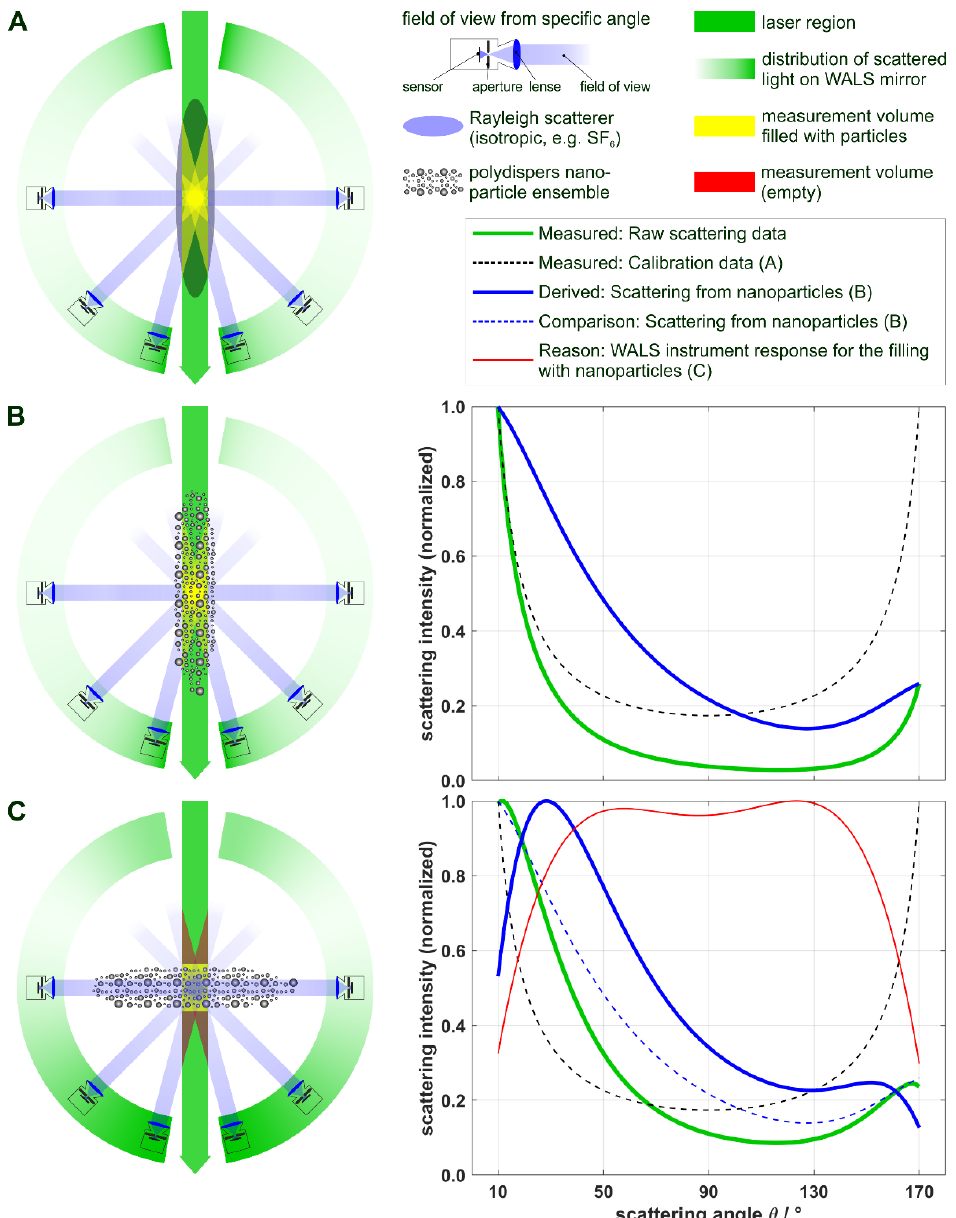
Figure 4. Illustration of WALS scattering patterns for isotropic scatterers ( A ) and a polydisperse particle ensemble ( B ), both filling the measurement volume homogeneously and completely; a non-homogeneous filling of the measurement volume and its characteristic scattering pattern is depicted in ( C ); scattering diagrams next to ( B , C ) show the raw scattering data (green), the calibration of the measurement volume from ( A ) (black dashed lines) and the derived scattering from particles (blue); in ( C ) the WALS instrument response (red) for this type of non-homogenous filling of particles is additionally given.